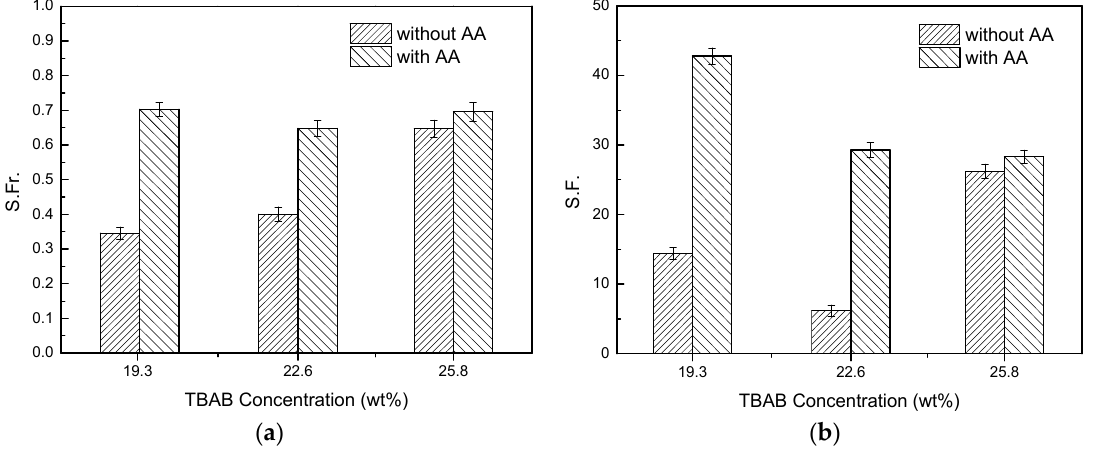
Figure 7. CO 2 split fraction ( a ) and separation factor ( b ) in different conditions.